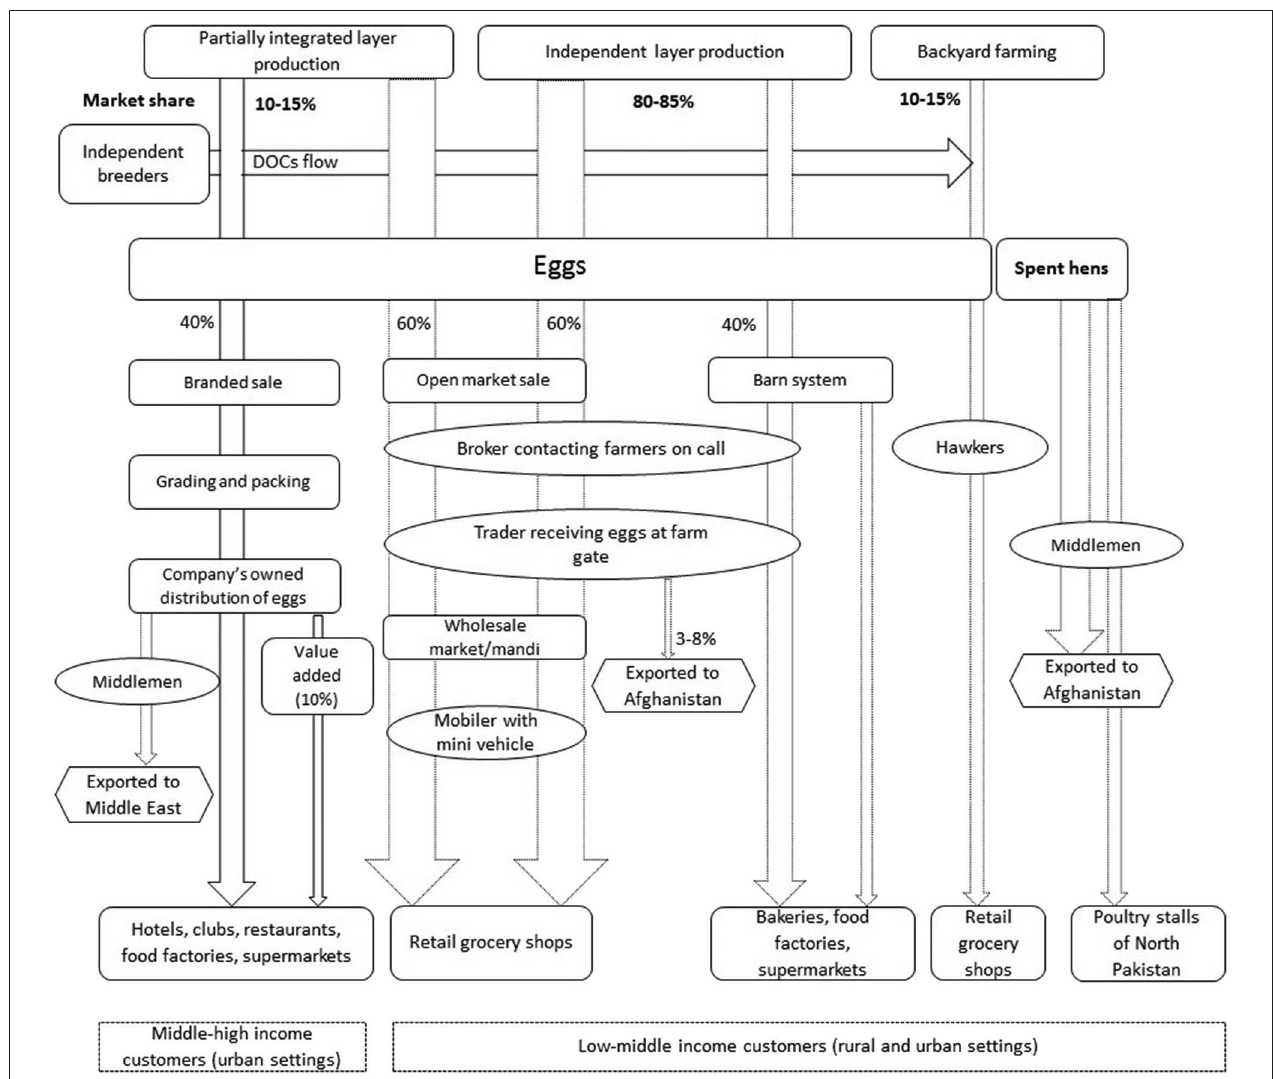
FIGURE 6 | Layer production systems in Pakistan, their market share and associated value chains. DOC indicates day old chicks, Mandi refers to the wholesale market for eggs. Dotted arrows show the chains operated by the middlemen, numbers in and around arrows, and width of the arrows indicate the market shares.